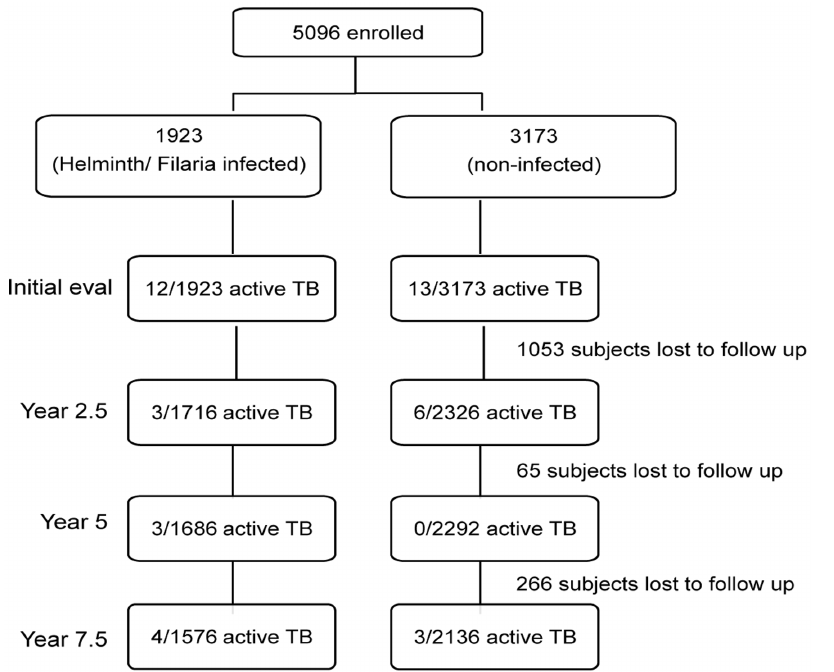
Figure 1. Flow diagram showing the numbers of subjects with active TB and total number evaluated, along with loss-to-follow-up at each evaluation time point of the study.